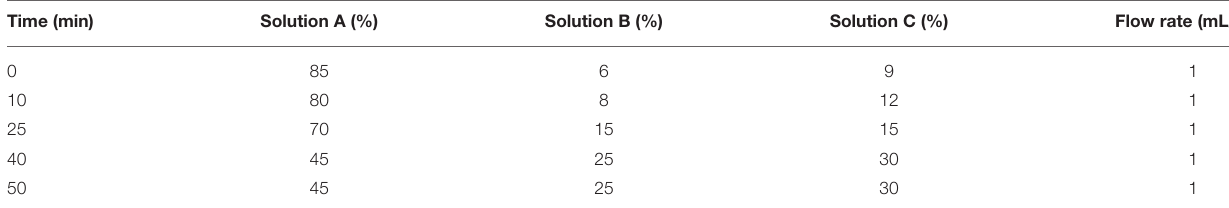
TABLE 2 | Gradient elution program of